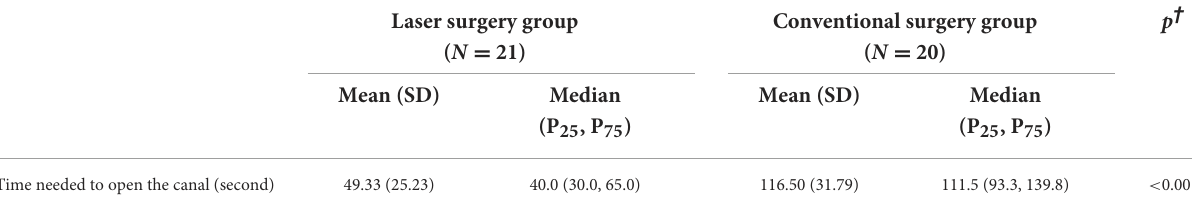
TABLE 3 Time needed to open SC for both groups. Excluding the cases wherein penetration occurred and resulted in failed identification of the